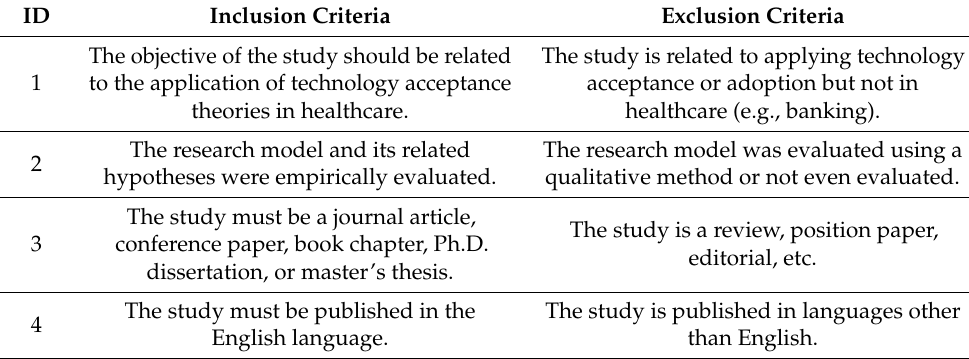
Table 2. Inclusion and exclusion criteria.